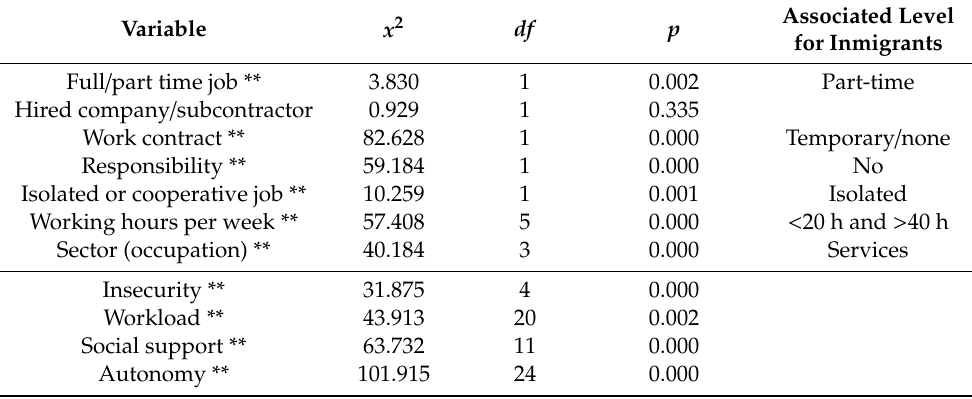
Table 3. Chi-square analysis of organizational variables and latent factors between migrant and native